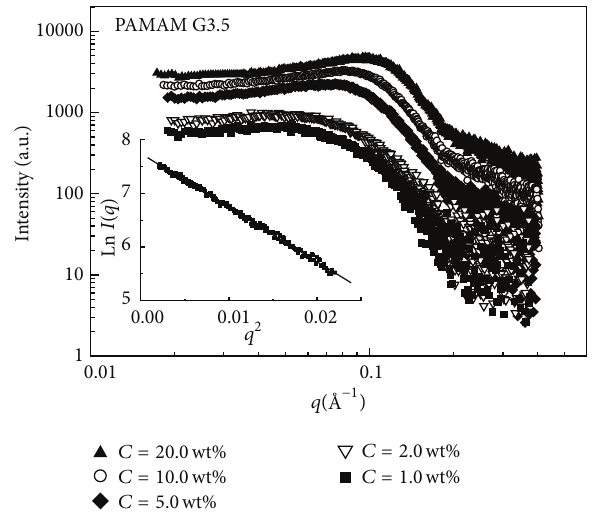
Figure2:SAXSintensityprofilesofmethanolsolutionofgeneration G3.5 (sodium carboxylate terminated) PAMAM dendrimers at different concentrations at 𝑇 = 23 ∘